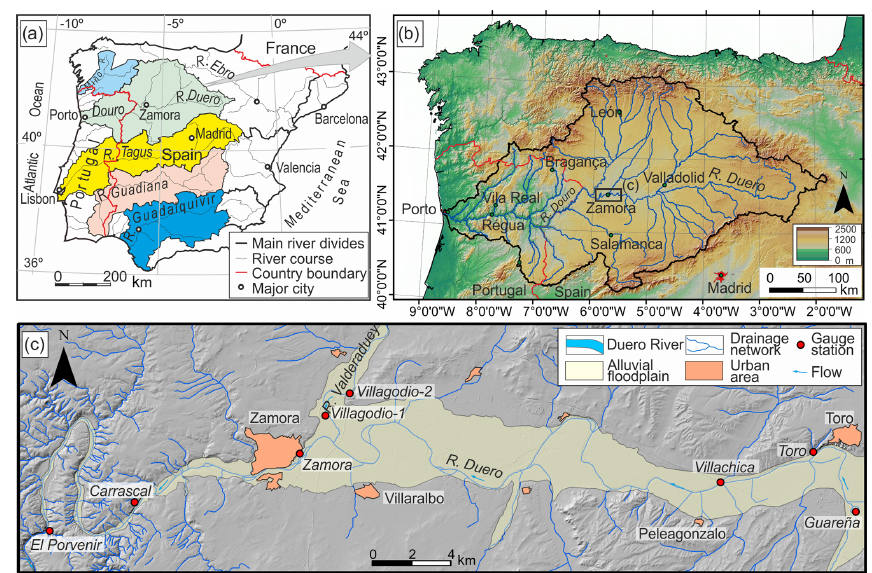
Figure 1. (a) The Duero River basin (green) in the Iberian Peninsula together with Miño (light blue), Tagus (yellow), Guadiana (orange) and Guadalquivir (dark blue) catchments draining towards the Atlantic Ocean; (b) relief map of NW Iberia with the Duero catchment boundary, main drainage network and major cities. The rectangle at Zamora shows the location of (c) ; (c) hillshade map with extension of the floodplain between Toro and Zamora. Map shows location of gauge stations in the Duero and Valderaduey